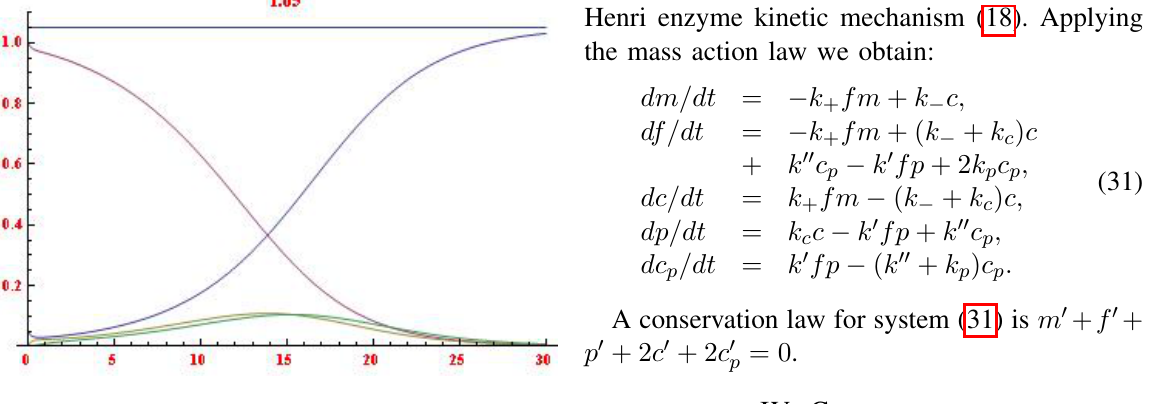
Fig. 6. Graph of the solutions m, f, c, p of model